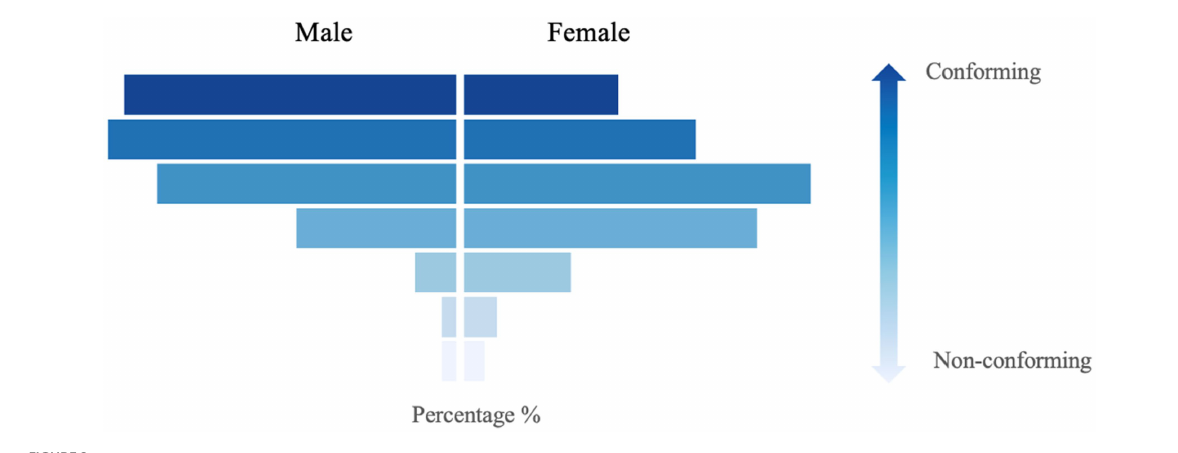
FIGURE 2 The distribution of gender-role conformity among male and female youths.